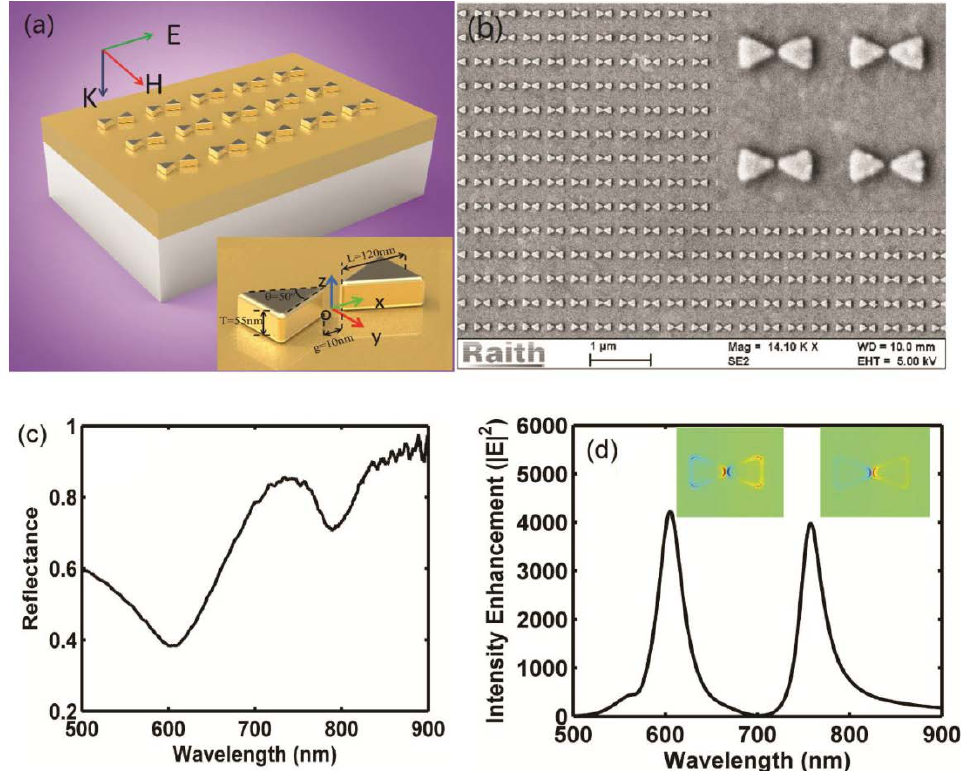
Figure 14: (a) Schematic of the dual-resonance Au device. (b) Picture of the fabricated nano-bowtie array on an opaque Au film. (c) Measured reflection spectrum for the nano-bowtie array. (d) Intensity enhancement spectrum obtained at the middle point of the gap with E z pro- files of the two resonances on the top surface of the bowtie structure. The structure parameters are indicated in (a) with an array period of 560 nm. Adapted from Ref.